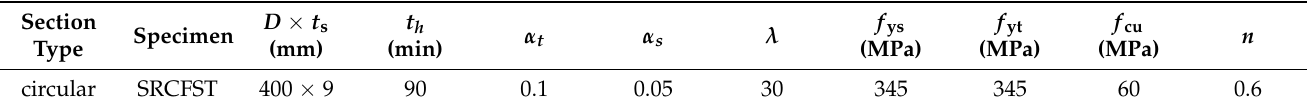
Table 2. Detailed information of SRCFST column.